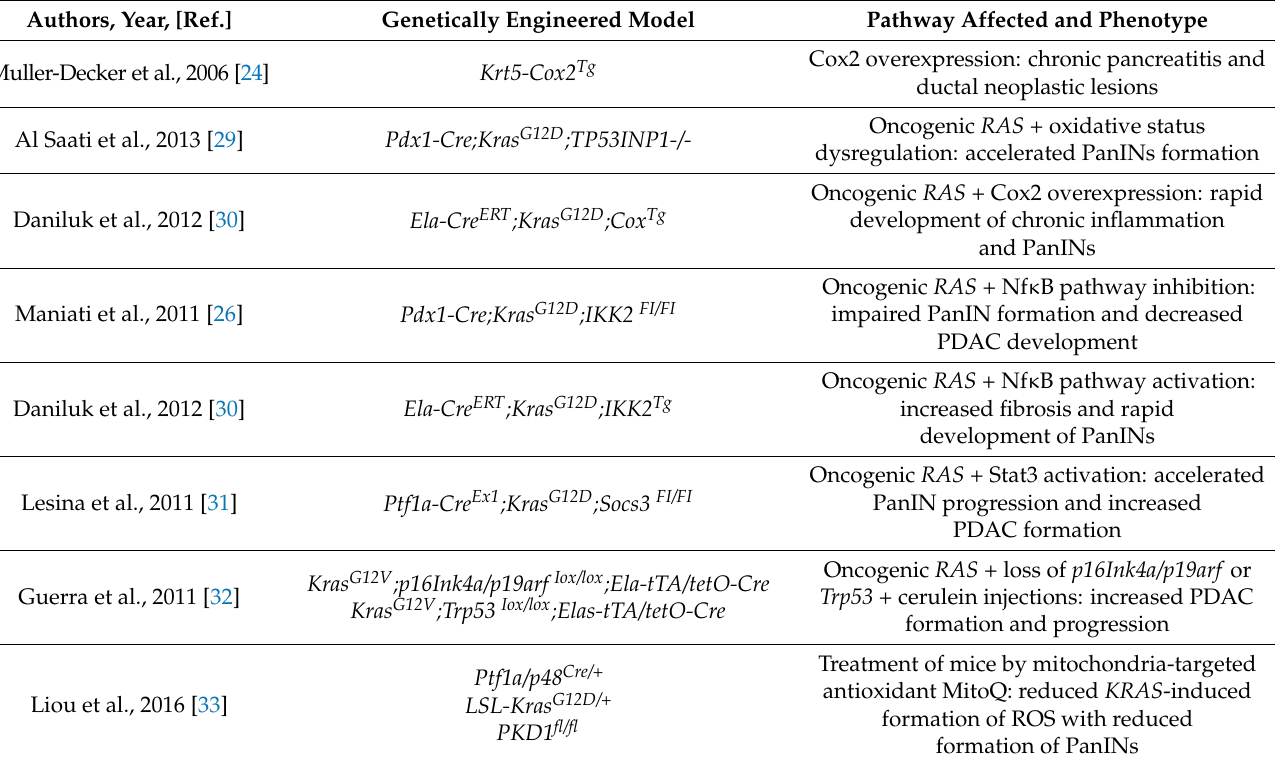
Table 1. Main genetically engineered mouse models demonstrating the role of inflammation in pancreatic